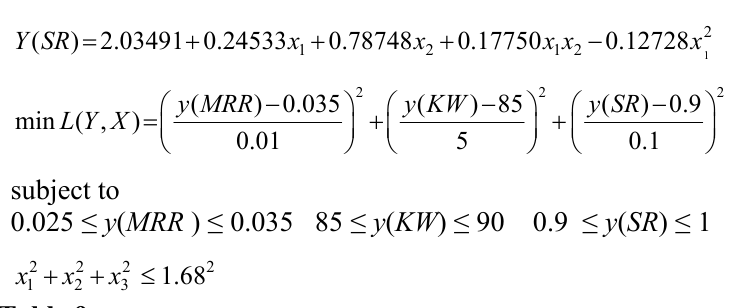
Comparison of the optimal parametric settings for micro-WEDM process Variable Response Optimization approach x 1 x 2 x 3 MRR KW SR Multivariate loss function approach